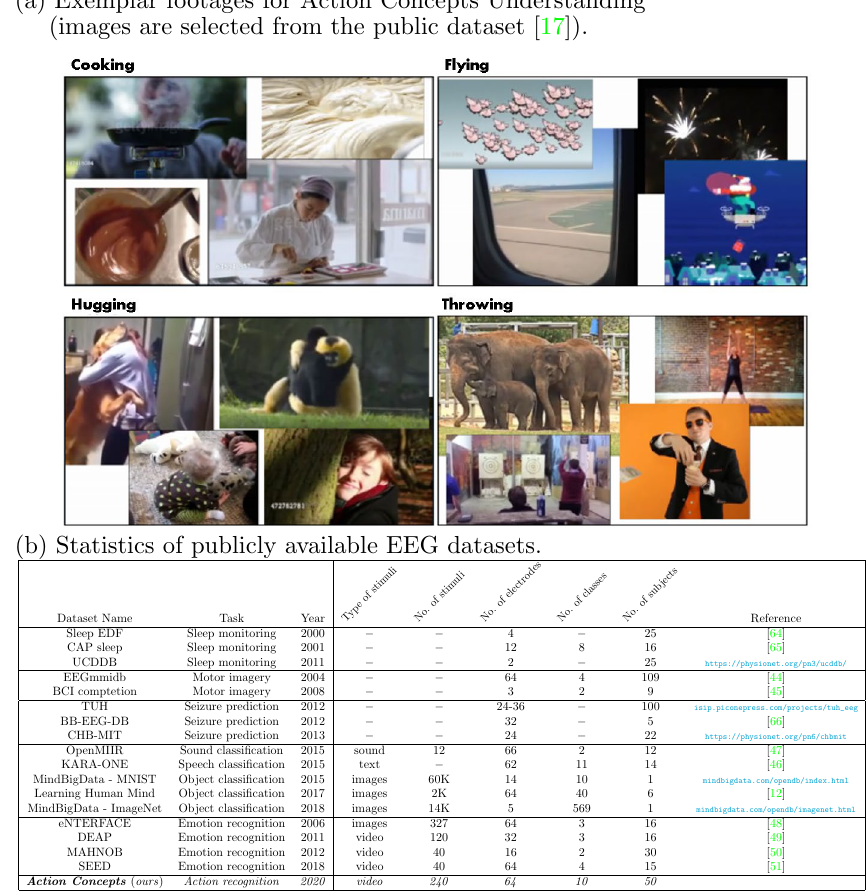
Figure 1. The action concepts dataset. ( a ) Example footages (from the publicly available dataset 17 ) related to some of the selected actions for the task of concept understanding, i.e., , recognizing actions that are implied as opposed to be explicitly visualized. The “Cooking” action is represented by the smoke coming out from a pan, the creation of a dough, the mixing of a chocolate cream, or the garnishing of a dessert ( top-left ). The “Flying” action is represented from footages in which pigs fly, fireworks are shot in the sky; alternatively, it is also depicted as a scene in which the panorama is filmed from an airplane window, and as Santa Claus delivering presents ( top-right ). For “Hugging”, unusual cases are considered such as a man hugging his dog, a girl hugging a tree, two gibbons hugging each others, and a baby hugging his toy ( bottom-left ). Similarly, for “Throwing”, elephants can throw sand on their backs, axes can be thrown, a weight can be thrown during a fitness sessions, and eventually money can be thrown in air ( bottom-right ). ( b ) Comparison of existing public benchmarks for EEG data processing, finalized to several